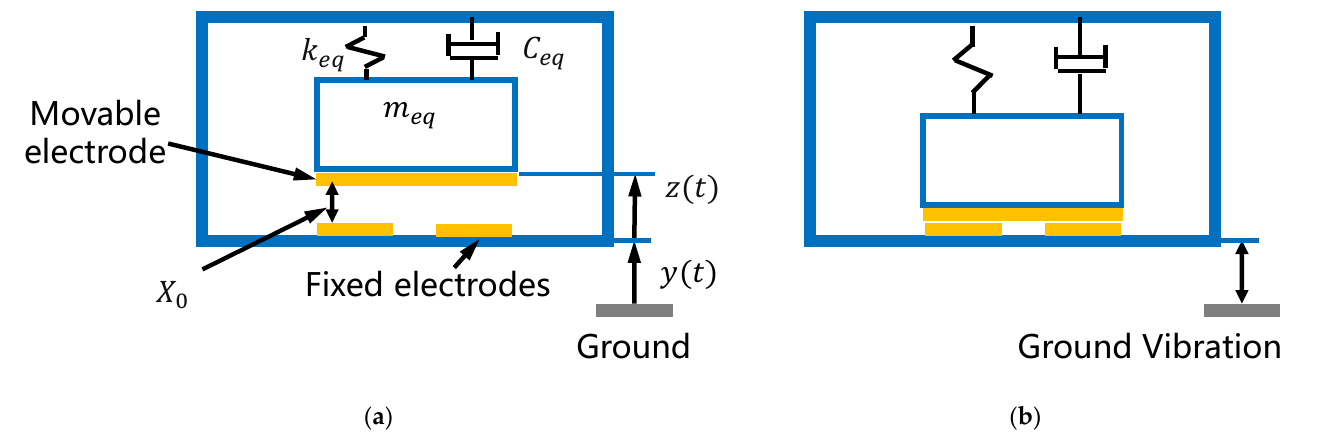
Figure 2. Cross section of the resonant acceleration switch. ( a ) Standby state; ( b ) closed state.